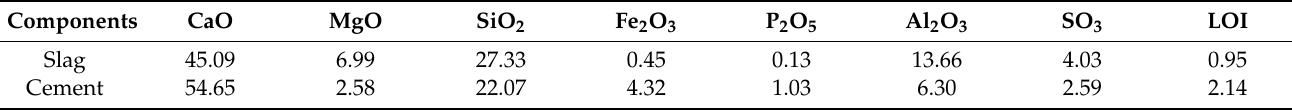
Table 1. Chemical component content of cementitious material (%).